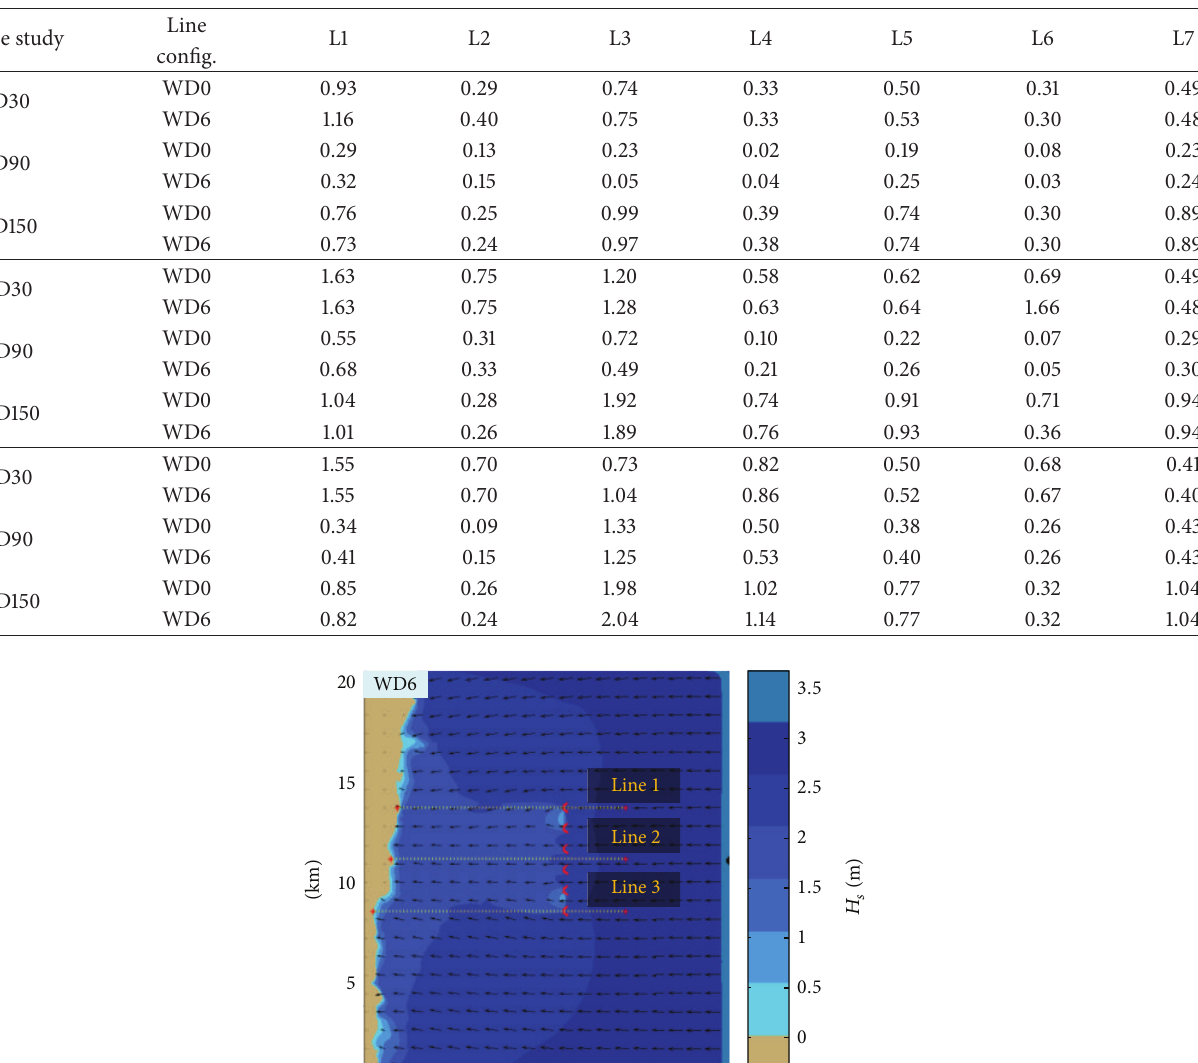
Table 7: Evaluation of the impact of the energy farms on the nearshore currents in terms of maximum current velocities along the reference lines RL1–RL7 for 𝐻 𝑠 = 1m, 𝐻 𝑠 = 3m, 𝐻 𝑠 = 5m, and three different wave directions (30 ∘ , 90 ∘ , 150 ∘ ). The two configurations (WD0 and WD6) were considered in parallel.